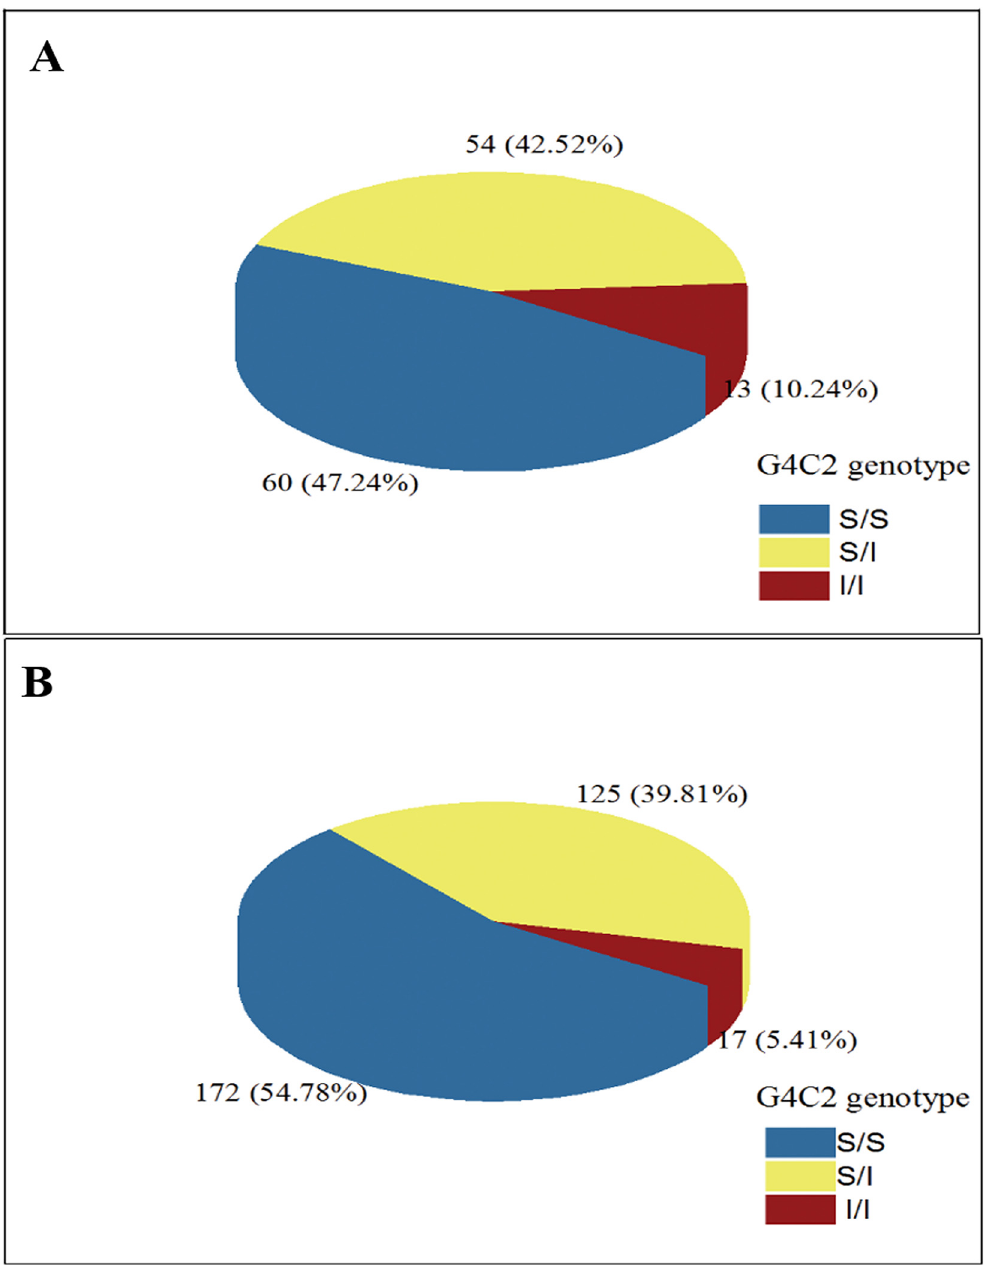
Fig 2. Frequencies of C9orf72 genotypes. A presents the frequencies in SCA3/MJD patients. B presents the frequencies in